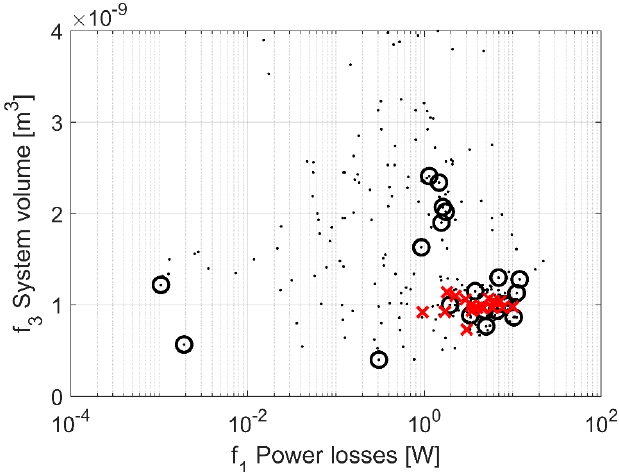
Figure 8. f 1 –f 3 projection of the objective space: dot—individuals, cross–NSGA-III solutions, circle—MP-NSGA solutions.